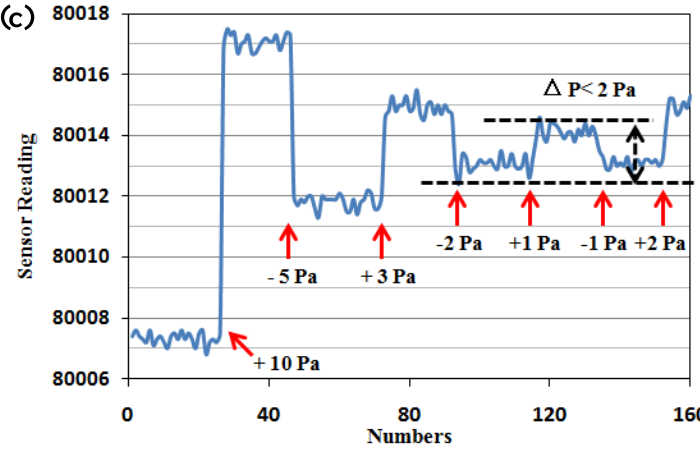
Figure 10. ( a ) The quantified error of the developed micro sensor in a temperature range from −40 °C to 60 °C and a pressure range from 50 kPa to 110 kPa; ( b ) The compared